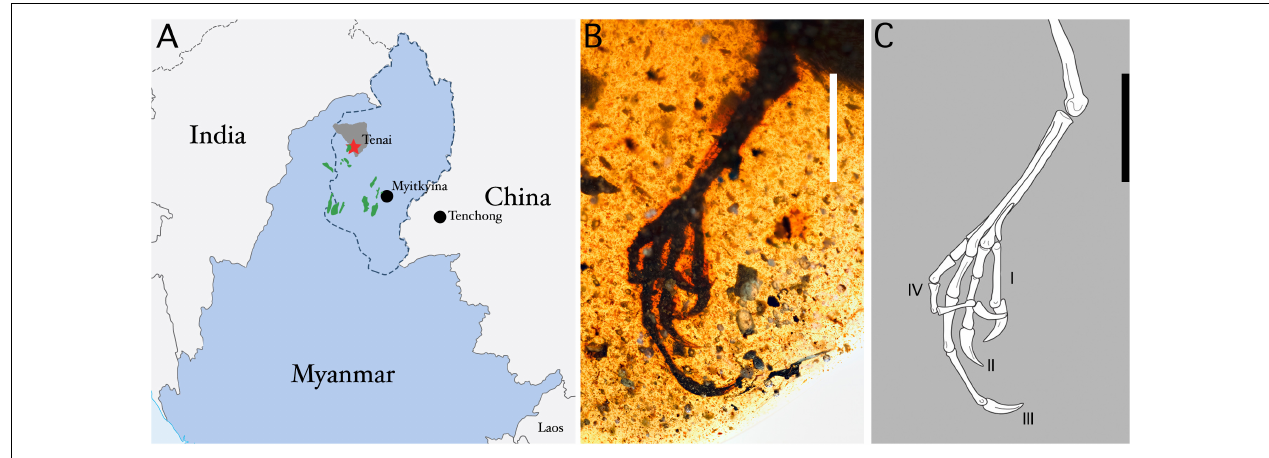
FIGURE 1 | (A) A map of the approximate location of the amber mines in Northern Myanmar where both specimens HPG-15-2 and YLSNHM01001 were discovered. Dark blue dotted outline = Kachin Province, gray shaded area = Hukawng Valley, red star = amber mines, and Tenai (Angbamo locality), green structures = Cretaceous-aged deposits. (B) The partial right hindlimb of Elektorornis chenguangi encased in amber (specimen HPG-15-2). (C) An interpretive osteological line-drawing of the partial right hindlimb of the Elektorornis chenguangi specimen, giving a clearer depiction of the proportionally elongated length of digit III. Scale bars = 5 mm. Photographs of specimens HPG-15-2 credited to Lida Xing, used with permission from Jingmai